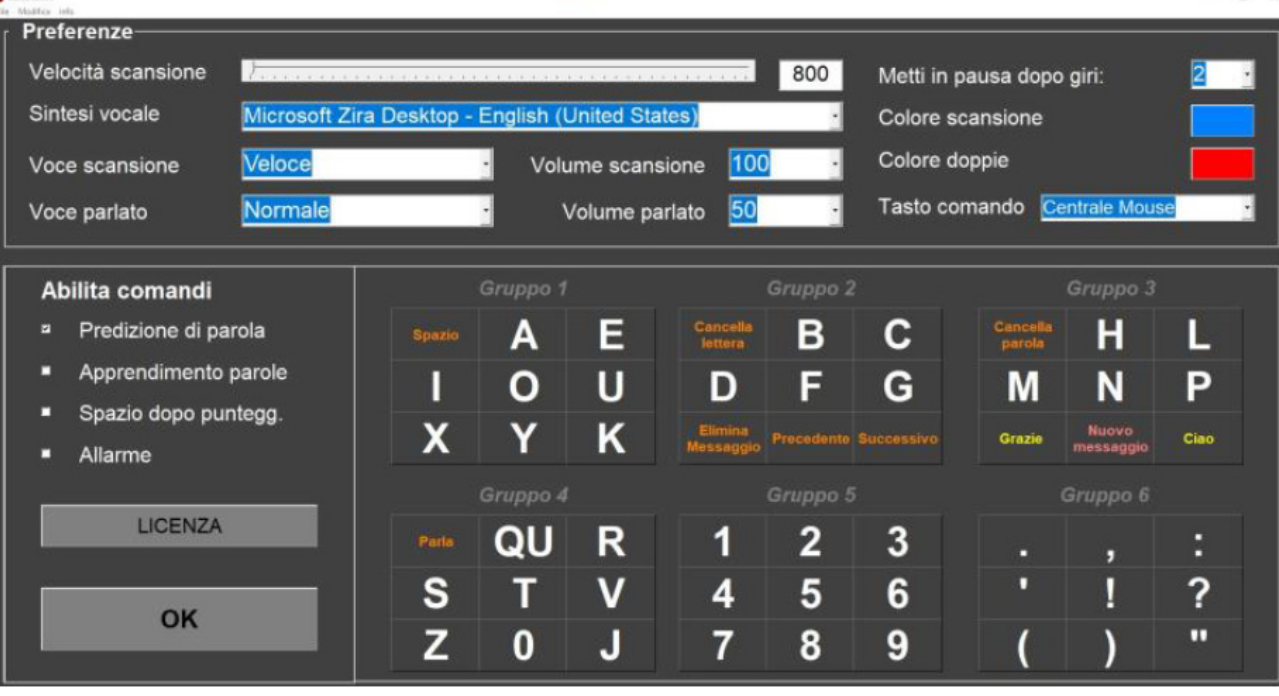
Figure A2. Screen with the program settings. EMOTIV EPOC®14 channels EEG headset. EMO- TIV®San Francisco, U.S.A.